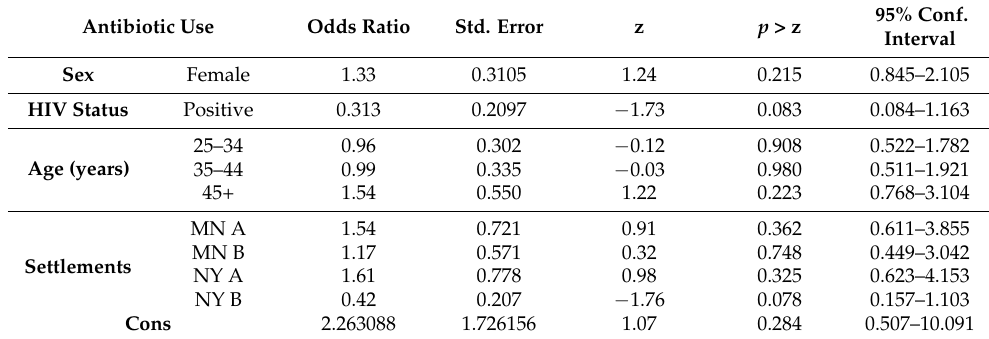
Table 3. Predictors of antibiotic